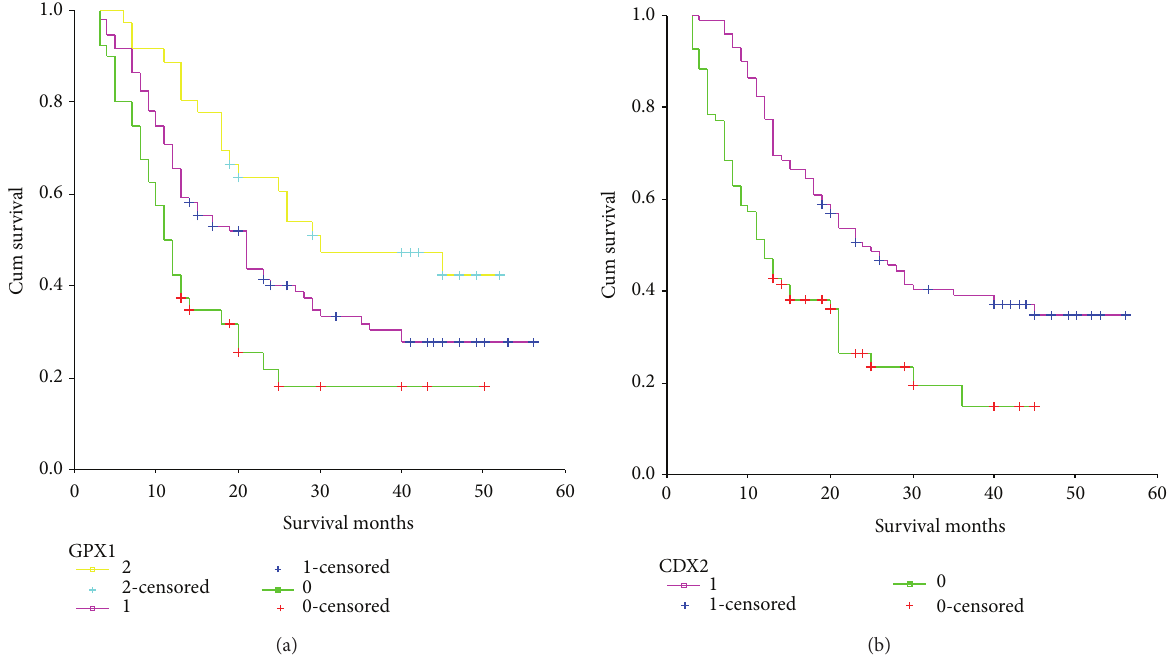
Figure2:Survivalcurveofgastriccancerpatients(a)GPX1highexpressiongroupcomparedwithGPX1weakexpressiongroupand(b)CDX2 positive expression group compared with CDX2 negative expression group ( 𝑃 = .030 and